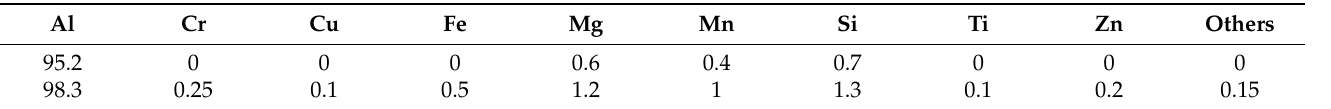
Table 1. Limits of the chemical composition of the aluminum alloy AW6082 [16]. Copyright 2020 Ansys Granata